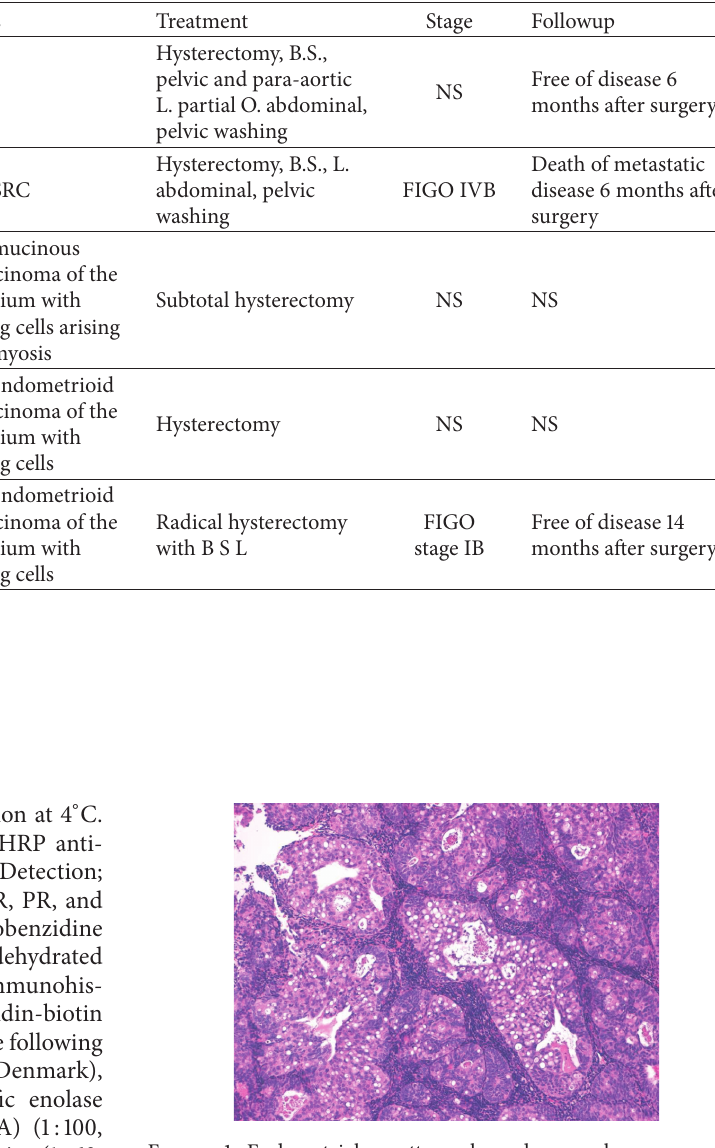
Figure 1: Endometrial curettage showed a neoplasm composed of glandular elements and solid areas with signet-ring cells (10x, hematoxylin and